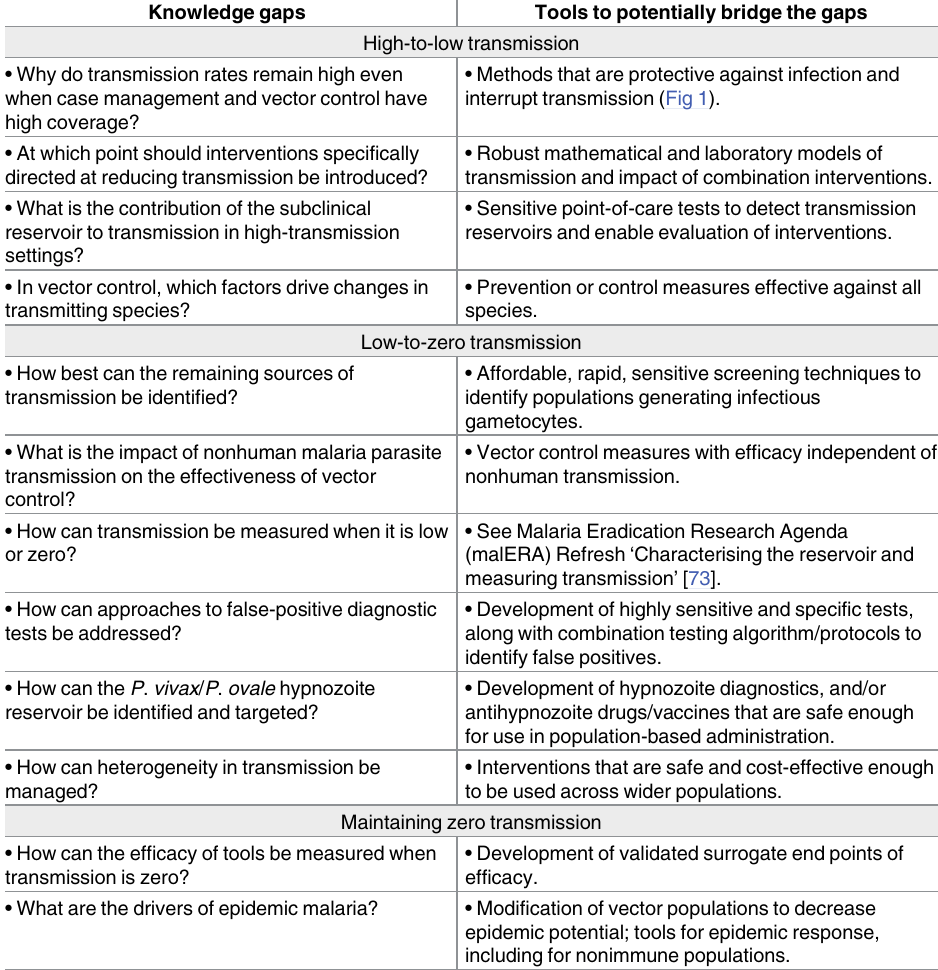
Table 2. Knowledge gaps and tools to potentially bridge the